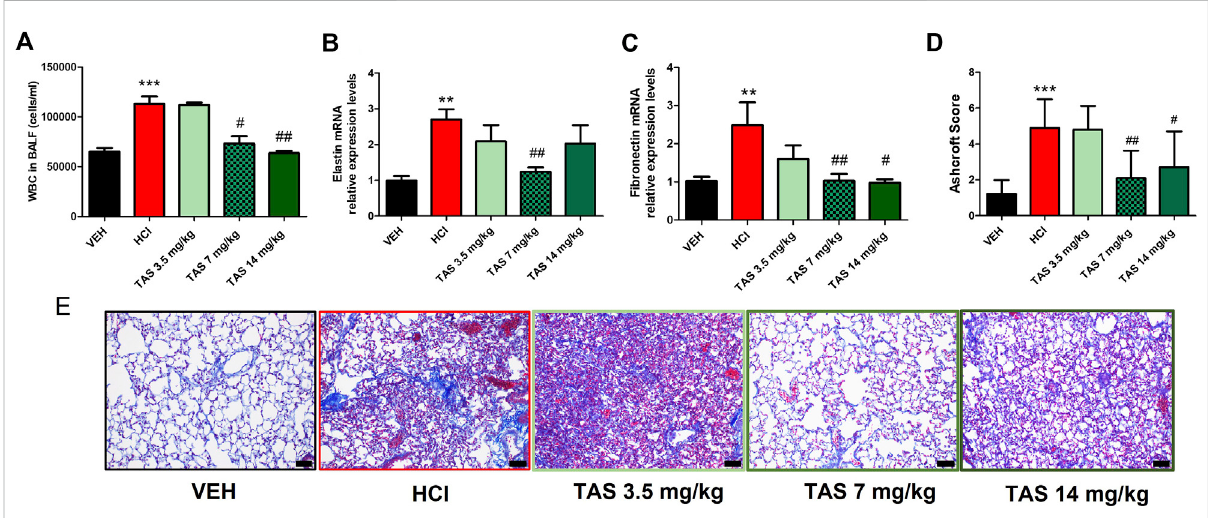
Analysisoflunginjuryafterintratrachealinstillatonof0.1NHClorsalinefollowedbytreatment,starting24 hlater,withtheHSP90inhibitorTAS- 116 (3.5, 7 or 14 mg/kg 5×/week p. o.) for 30 days. Content of white blood cells in bronchoalveolar lavage fl uid (BALF) n = 6 (A) ; relative expression levels of Elastin (B) and Fibronectin (C) mRNA were analyzed by RT-PCR, n = 4 – 5 ; Ashcroft Score (D) and Masson ’ s Trichrome staining (E) of lung sections, n = 3 . Original magni fi cation ×20; black scale bars correspond to 50 µm; *: p < 0.05; **: p < 0.01, ***: p < 0.01, from VEH; # : p < 0.05, ## : p < 0.01 from HCl, with 1-way ANOVA and Tukey ’ s post-hoc test.